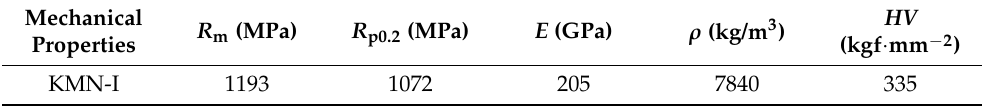
Table 1. Mechanical properties of KMN-I.